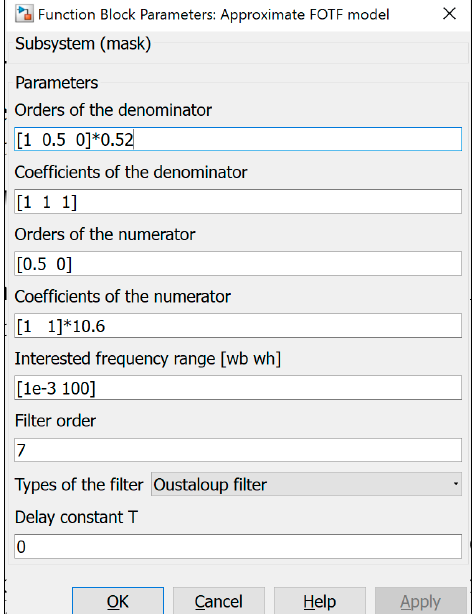
Figure 11. Computer Simulink model based on structural models of the eddy currents’ influence with an approximation of R ω of a fractional order block.